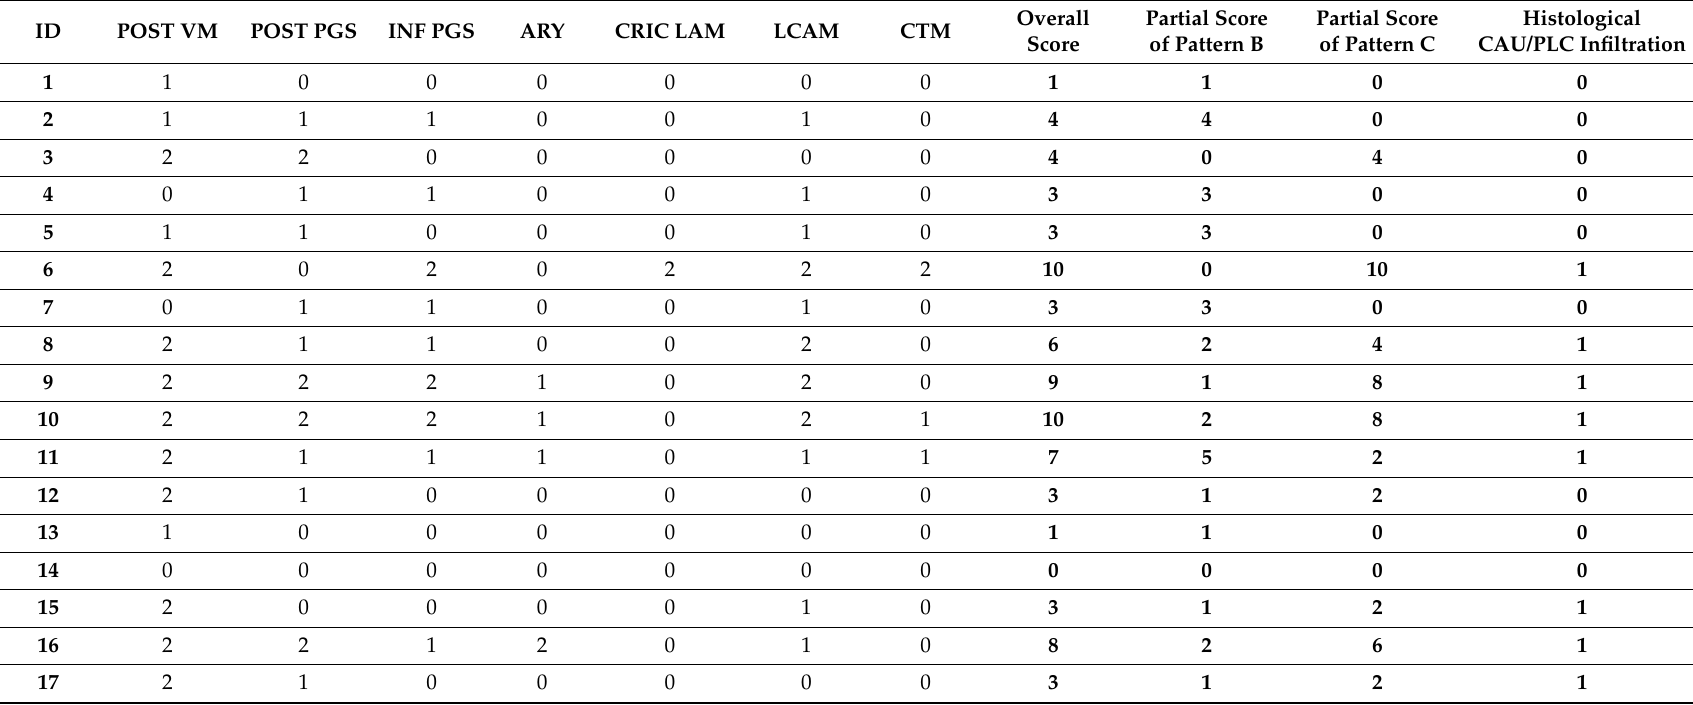
Table 2. Magnetic resonance (MR) signal changes in PLC subsites. Legend: POST, posterior; VM, vocal (thyro-arytenoid) muscle; PGS, paraglottic space; ARY, arytenoid cartilage; CRIC LAM, cricoid lamina; LCAM, lateral crico-arytenoid muscle; CTM, crico-thyroid muscle; CAU, crico-arytenoid unit; PLC, posterior laryngeal